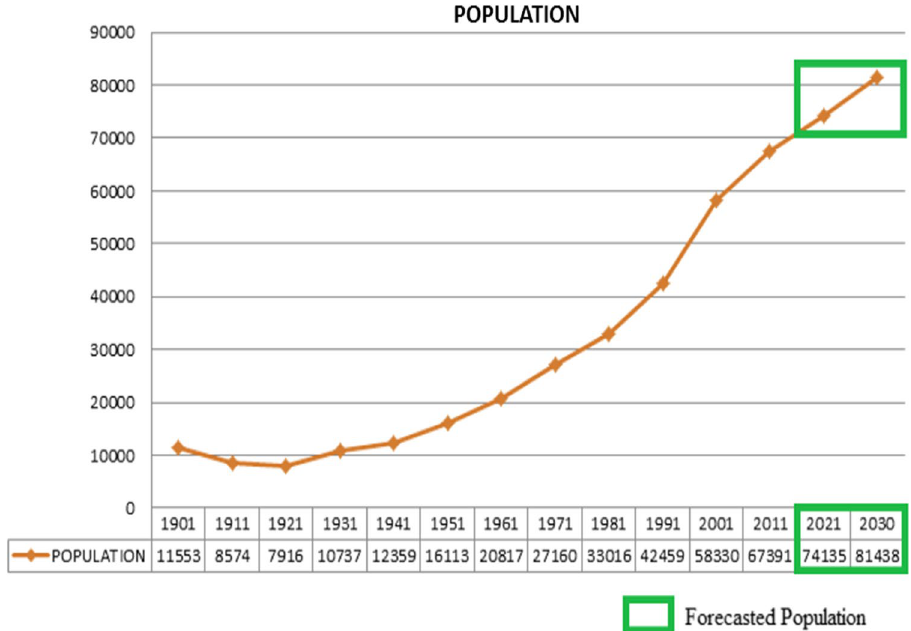
Fig. 2 Population of Urun- Islampur. Source : Census